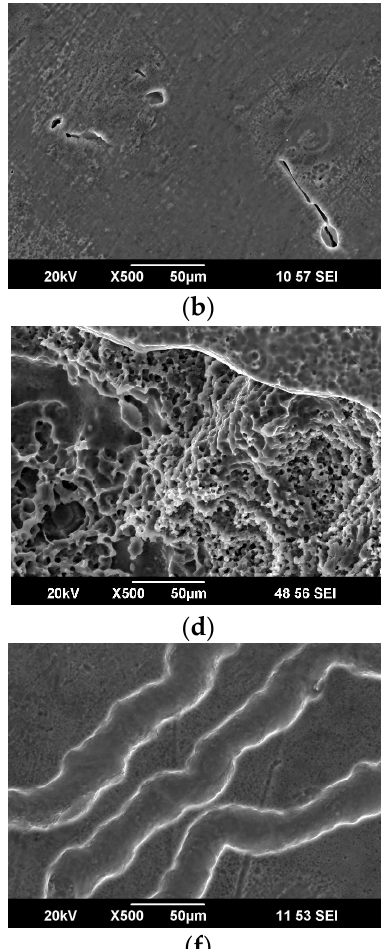
Figure 2. Corrosion rate of the Mg ‐ 1%Zn ‐ 0.2%Ca samples exposed in Ringer’s solution for a period of 1 to 32 days.